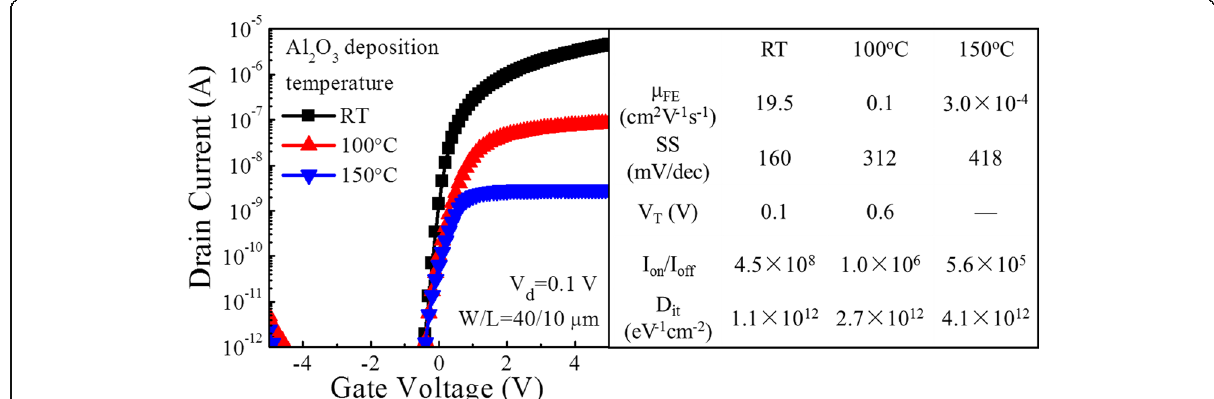
Fig. 2 Transfer curves of the a-IGZO TFTs with ALD Al 2 O 3 gate insulators deposited at different temperatures together with the extracted device parameters